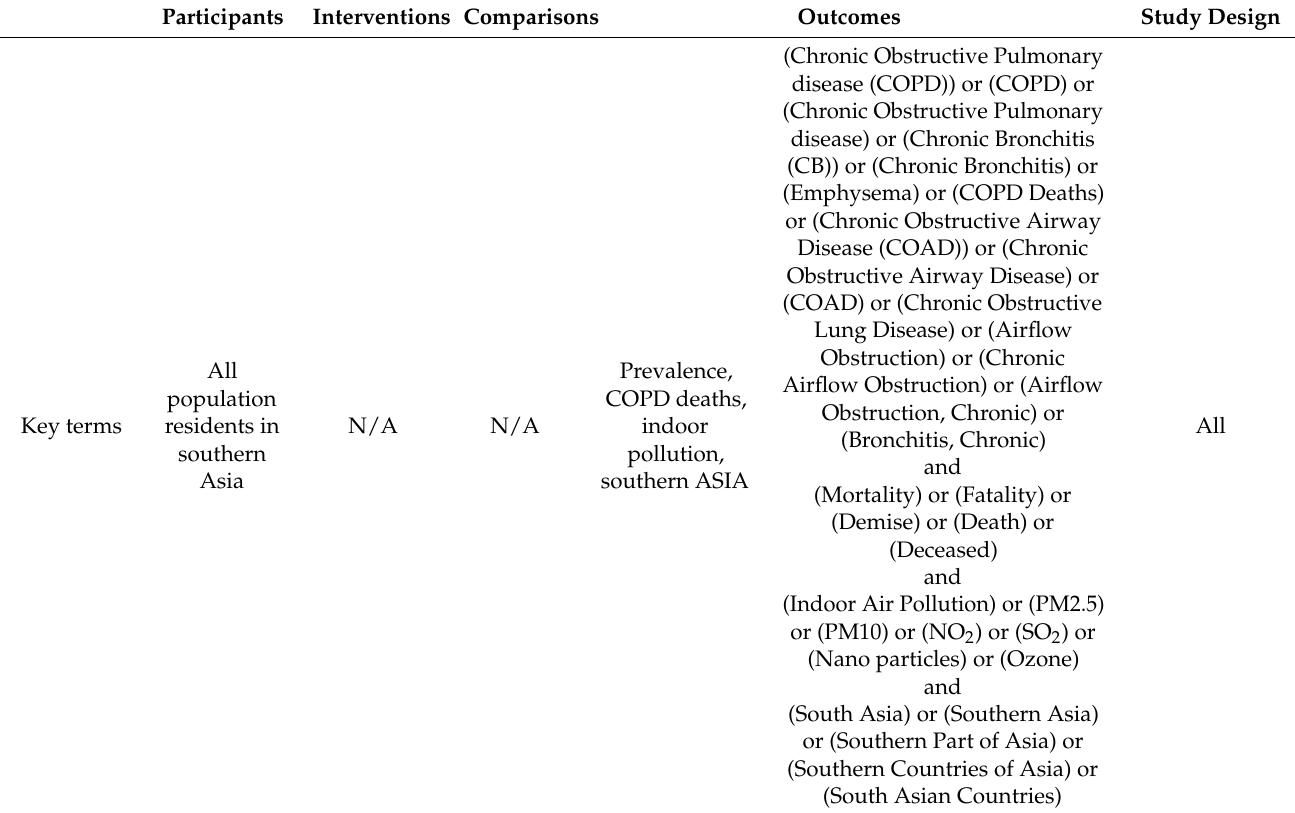
Table 1. Participants, interventions, comparisons, outcomes, and study design (PICOS) identifiers from research questions (‘key terms’) used to generate database